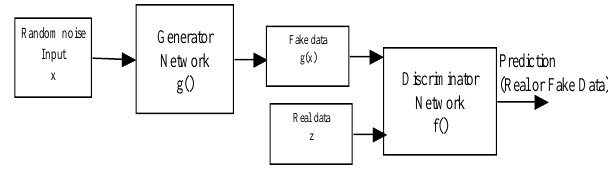
Figure 7. Generative adversarial network.